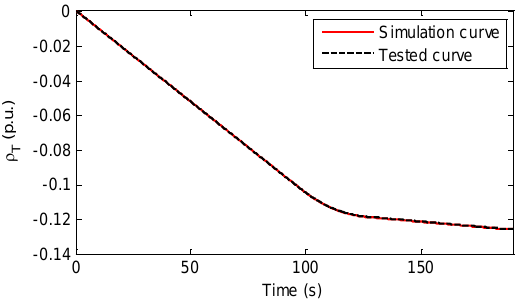
Figure 10. Reactor power control module simulation comparison.